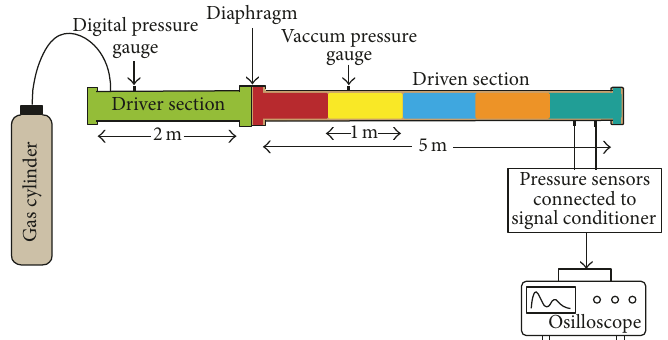
Figure 1: Shock tube facility present at IIT Guwahati.